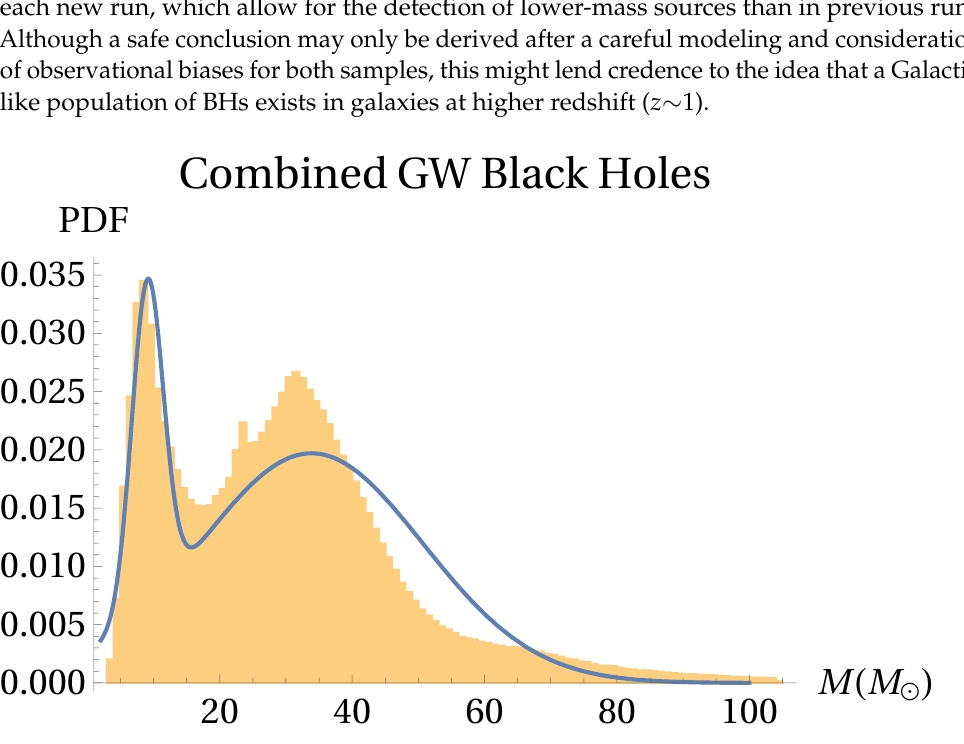
Figure 9. Mixed sample resulting from a draw of 10 6 masses from each BH component from GWTC-3 (yellow histogram) and the resulting best double Gaussian fit (blue line), with parameters given in the